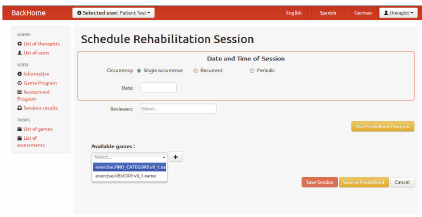
Figure 13: Scheduling cognitive rehabilitation